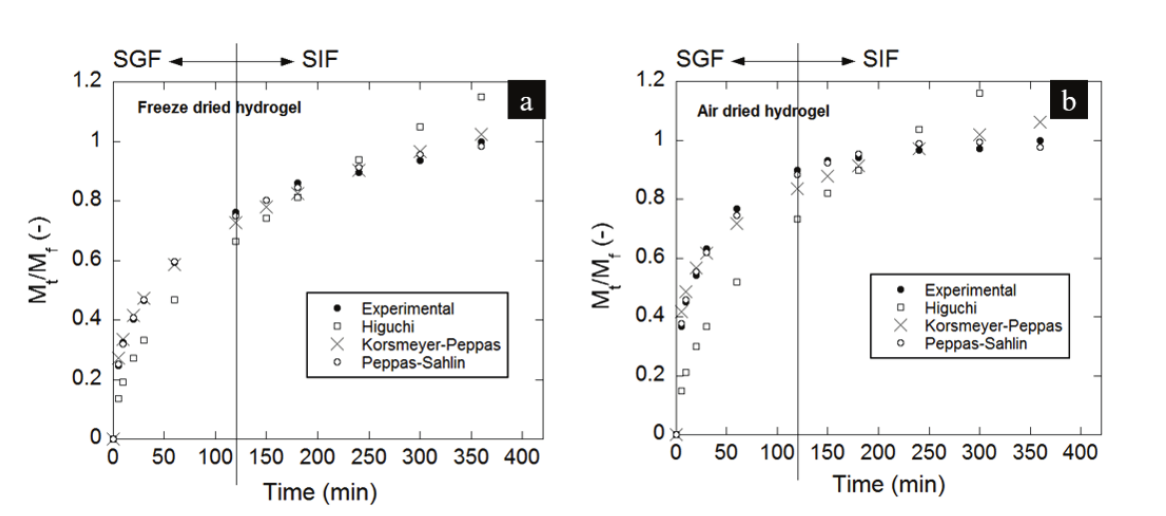
Figure 4 - Water absorption data of gelatin hydrogels ( a ) freeze-dried (FDH); ( b ) air-dried (ADH); in simulated gastric fluid (SGF) and simulated intestinal fluid (SIF). Experimental data (●) and modeled data obtained by Higuchi (□), Korsmeyer-Peppas (×), and Peppas-Sahlin (○)